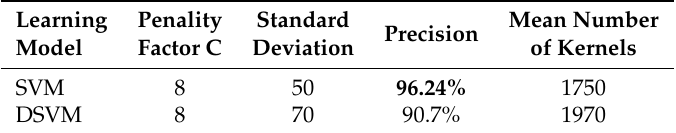
Table 3. Optimal parameters for the models for the scenes with 512 × 512 resolution. The bold value simply indicates the maximum precision.